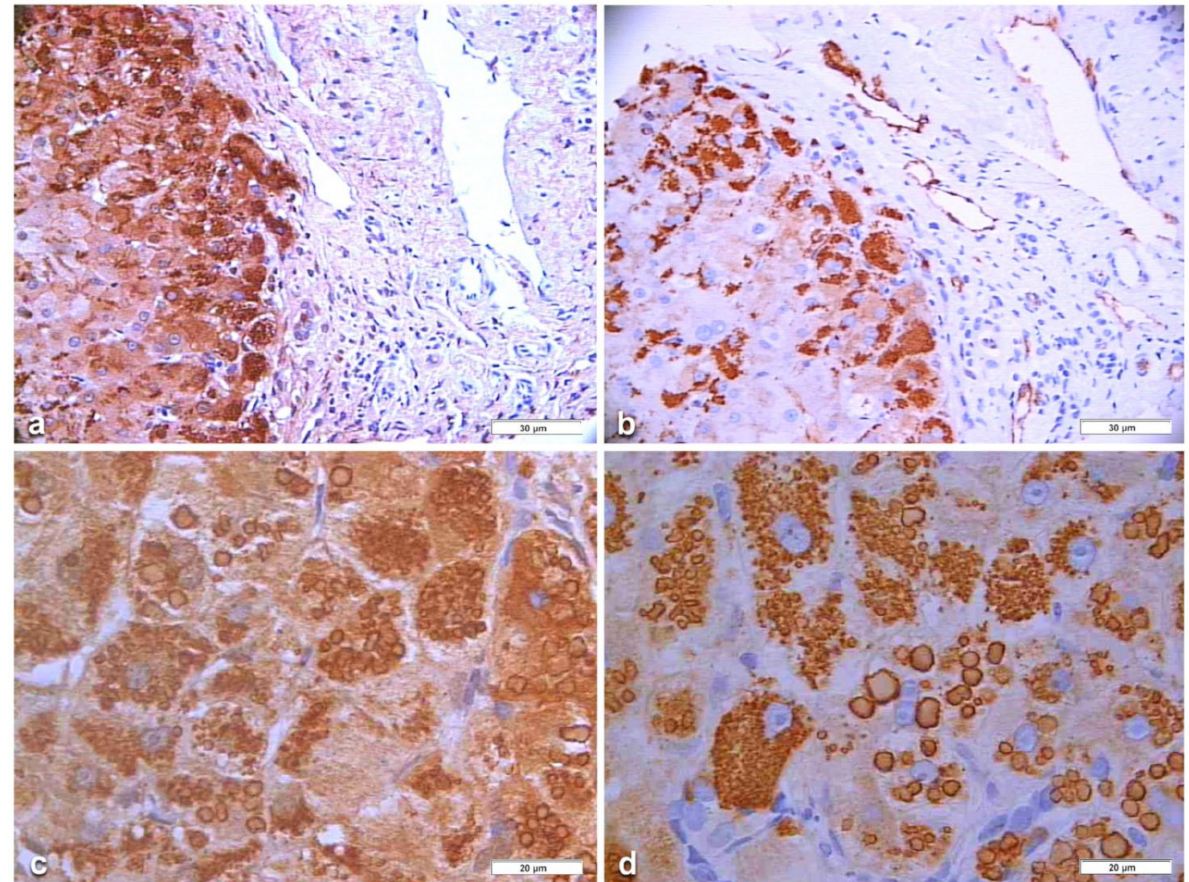
Figure 6. Pi MZ liver. AAT immunoreactive inclusions fill up the entire cytoplasm of periportal hepatocytes ( a ) polyclonal anti-AAT immunostaining 40 × . A consecutive section stained with a monoclonal AZT antibody shows less intense staining. Single inclusions have a sharply demarcated periphery. Endothelial cells of portal vessels are stained by the monoclonal but not by the polyclonal one ( b ) monoclonal AZT antibody 40 × . Two consecutive sections from a Pi MZ liver. Both sections show a high degree of storage and large size of globules. The staining intensity of the polyclonal-AAT section appears higher with the AAT polyclonal ( c ) immunostaining × 100 than with the monoclonal ( d ) immunostaining 100 ×